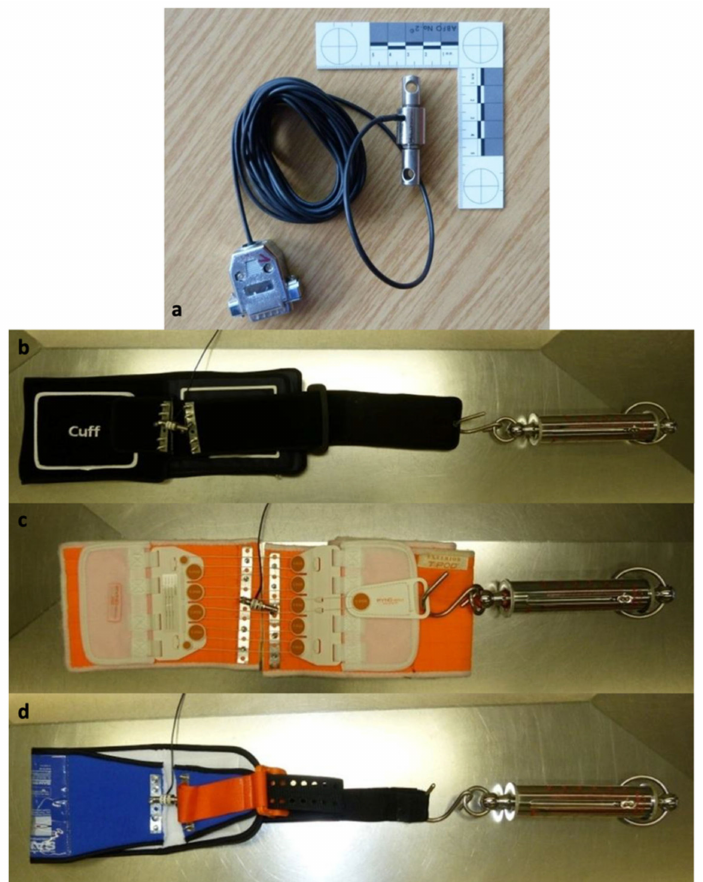
Figure 1. Used devices: ( a ) Newtonmeter; ( b ) Pneumatic pelvic sling VBM ® prepared with New- tonmeter and tension spring; ( c ) T-POD ® prepared with Newtonmeter and tension spring; ( d ) SAM Sling ® prepared with Newtonmeter and tension spring (source: Haussmann [22],